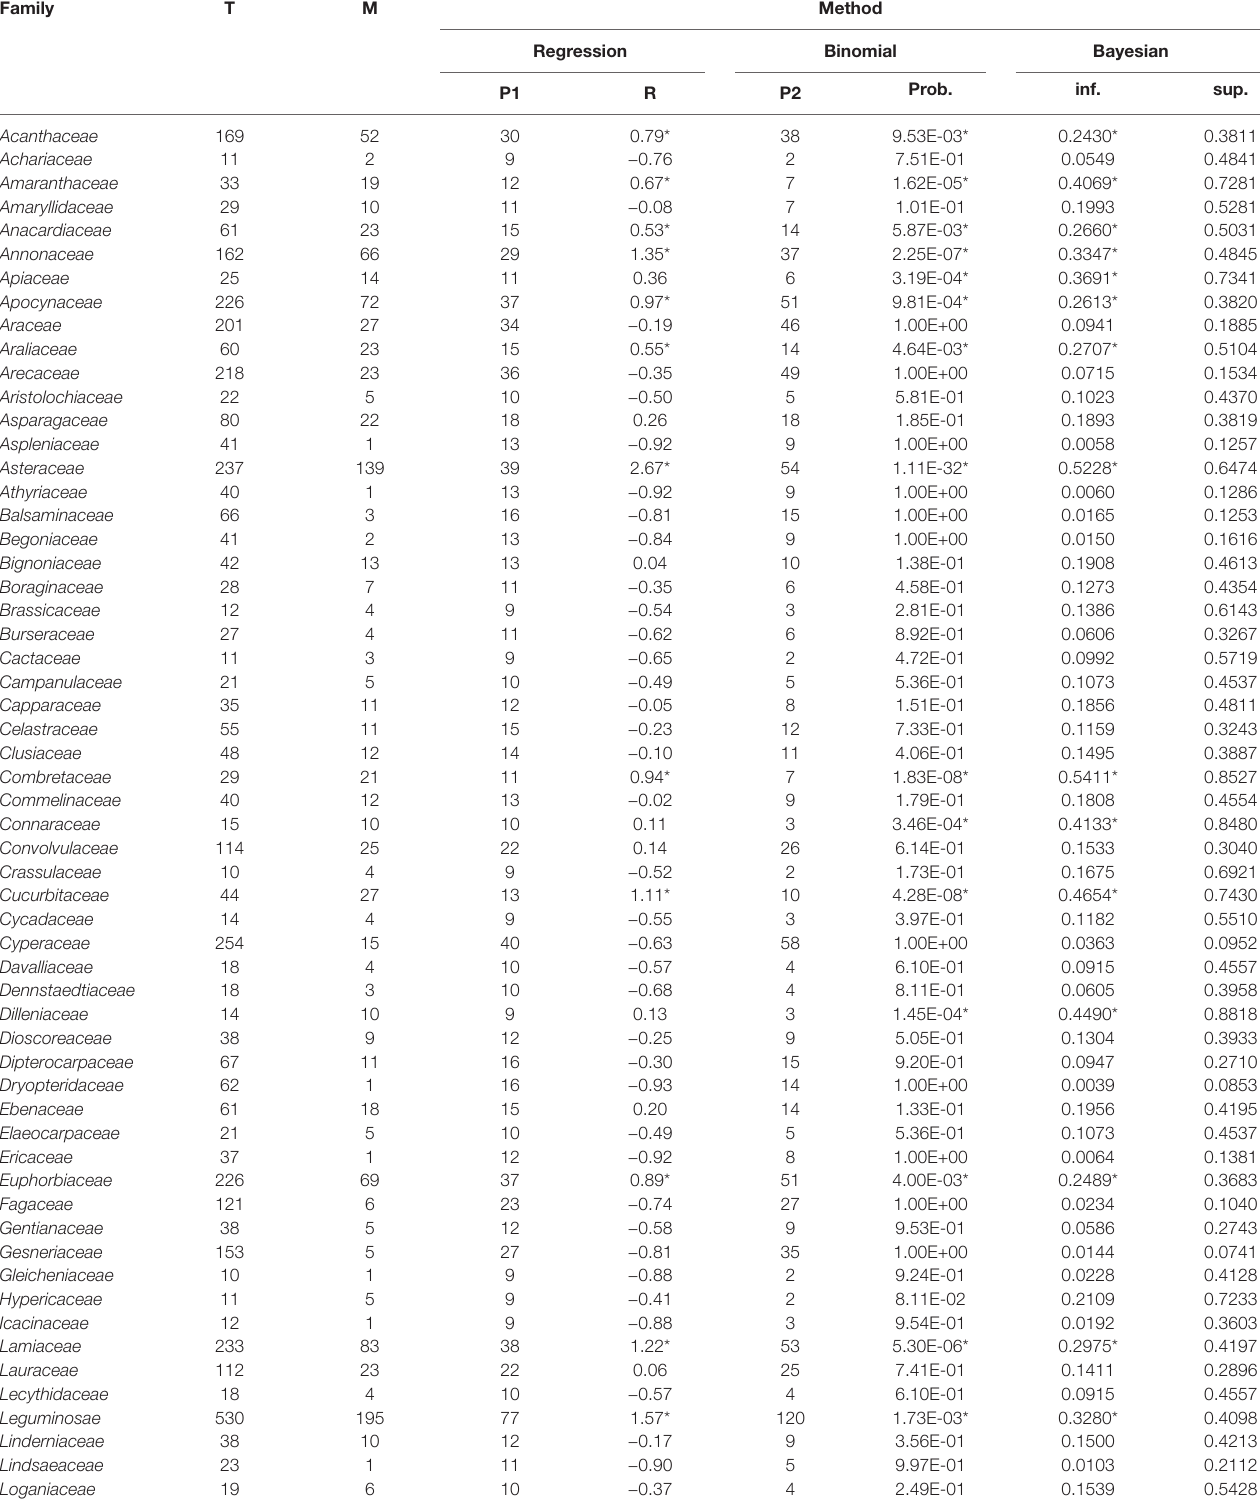
TaBle 1 | Medicinal importance of all plant families in Thailand containing more than 10 species as revealed by three statistical approaches: regression residual analysis, binomial analysis and Bayesian analysis.